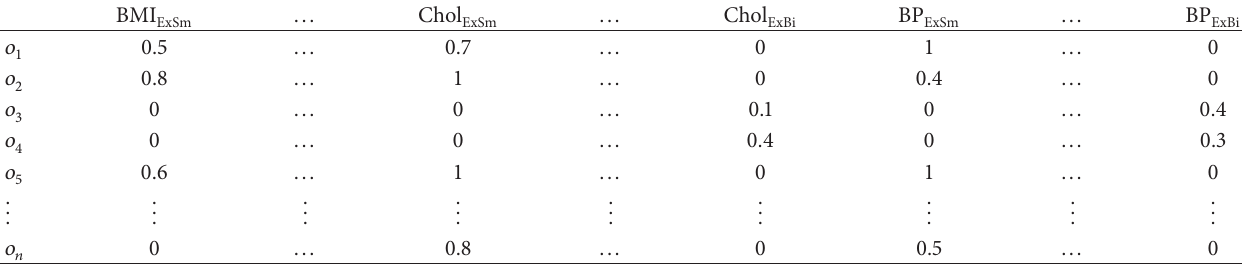
Table 6: Example of fuzzy GUHA table (compared with Table 4). BMI